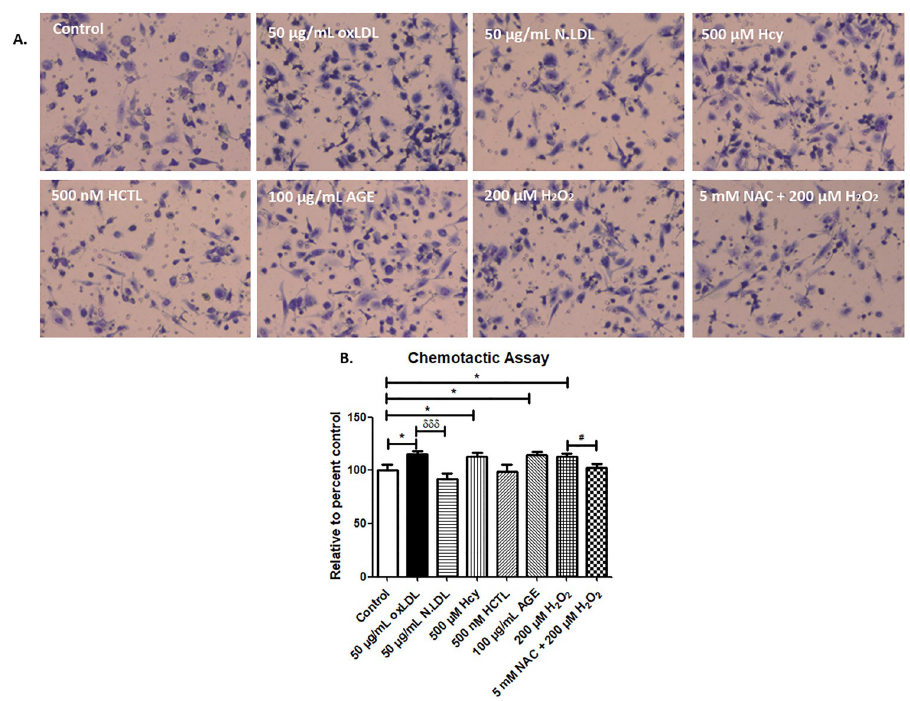
Fig 3. Chemotactic assay of THP-1 macrophages. (A) Transwell migration of THP-1 macrophage in response to the cytokine secretion of ARPE-19 cells exposed to pro-oxidant conditions for 24 h was assessed after 4 h incubation. The migrated macrophages were stained with Giemsa stain and five random fields were captured per well with Nikon Eclipse Ts2 microscope at 10X magnification. (B) Bar chart showing the number of migrated macrophages, represented as relative percentage to control. Values are expressed as Mean ± SEM, n = 3. � p < 0 . 05 , δδδ p < 0 . 001 , considered as significant. � Control vs pro-oxidants, # H 2 O 2 vs NAC, δ oxLDL vs N.LDL.